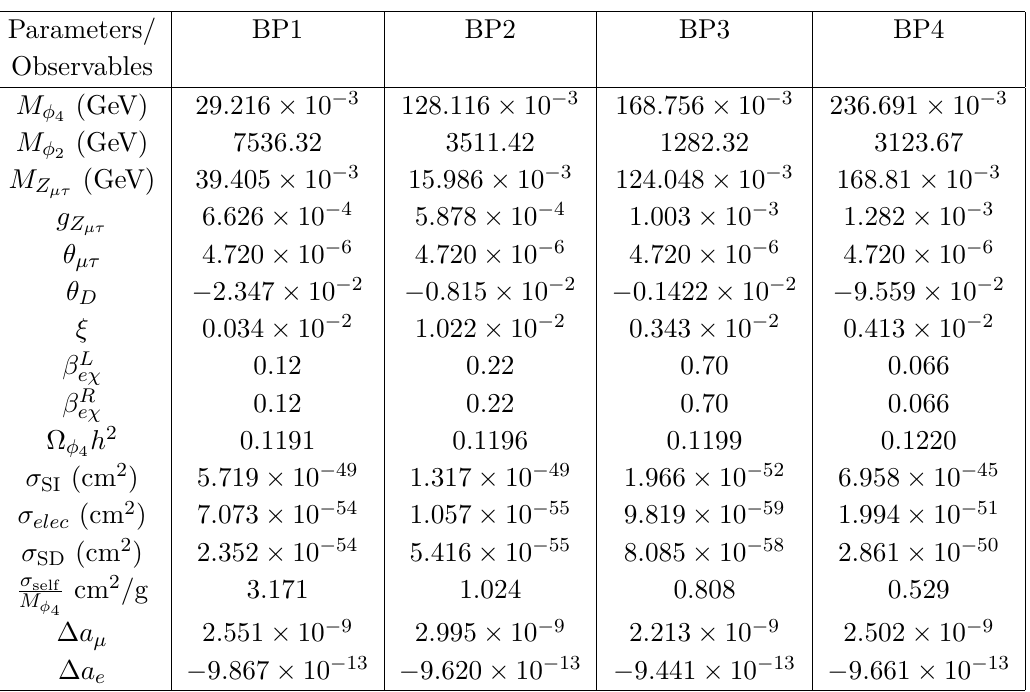
Table 7 . Plausible four benchmark points (BP1, BP2, BP3 and BP4) with the numerical values of other physical quantities considered in this